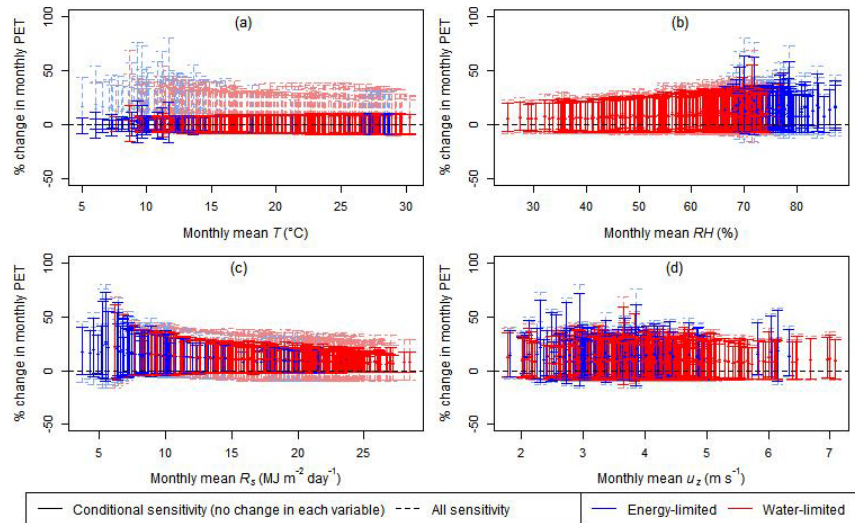
Figure 6. Range of monthly PET responses from the Priestley–Taylor model, plotted against the monthly baseline levels of (a) temperature, (b) relative humidity, (c) solar radiation and (d) wind speed at 30 study sites. Each dashed (solid) line represents the range of all potential change in PET in response to the full set of climate perturbations (conditioned on no change in each climate variable) for a single month at a single location. The corresponding means are represented by the points on the lines. The classification of energy- and water-limited months is based on the corresponding monthly PET /P ratios.